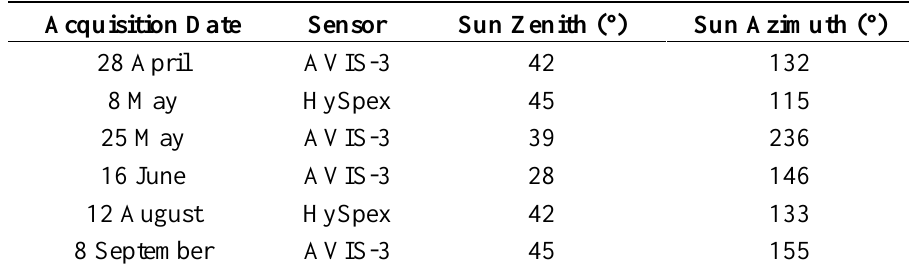
Table 1. Airborne data acquisitions over the Neusling test